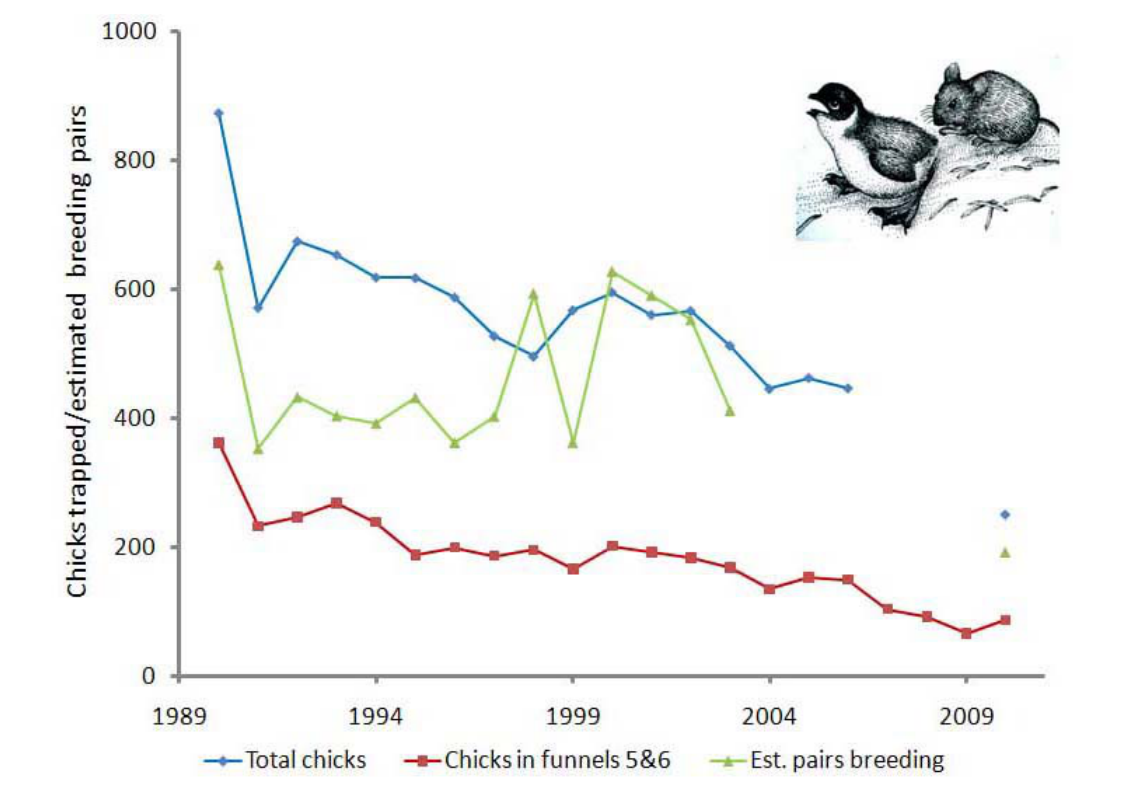
Fig. 2 . Total chicks captured in all funnels at East Limestone Island during 1990-2010 (corrected for years before 1996); total chicks captured in funnels 5 and 6 and estimated size of breeding population within the catchment area (years for which breeding success was available